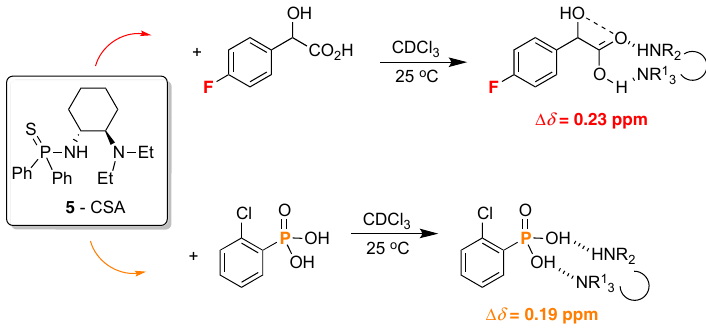
Scheme 4. Chiral thiophosphoramide 6 as a CSA for a variety of carboxylic acids by 19 F { 1 H} and 31 P